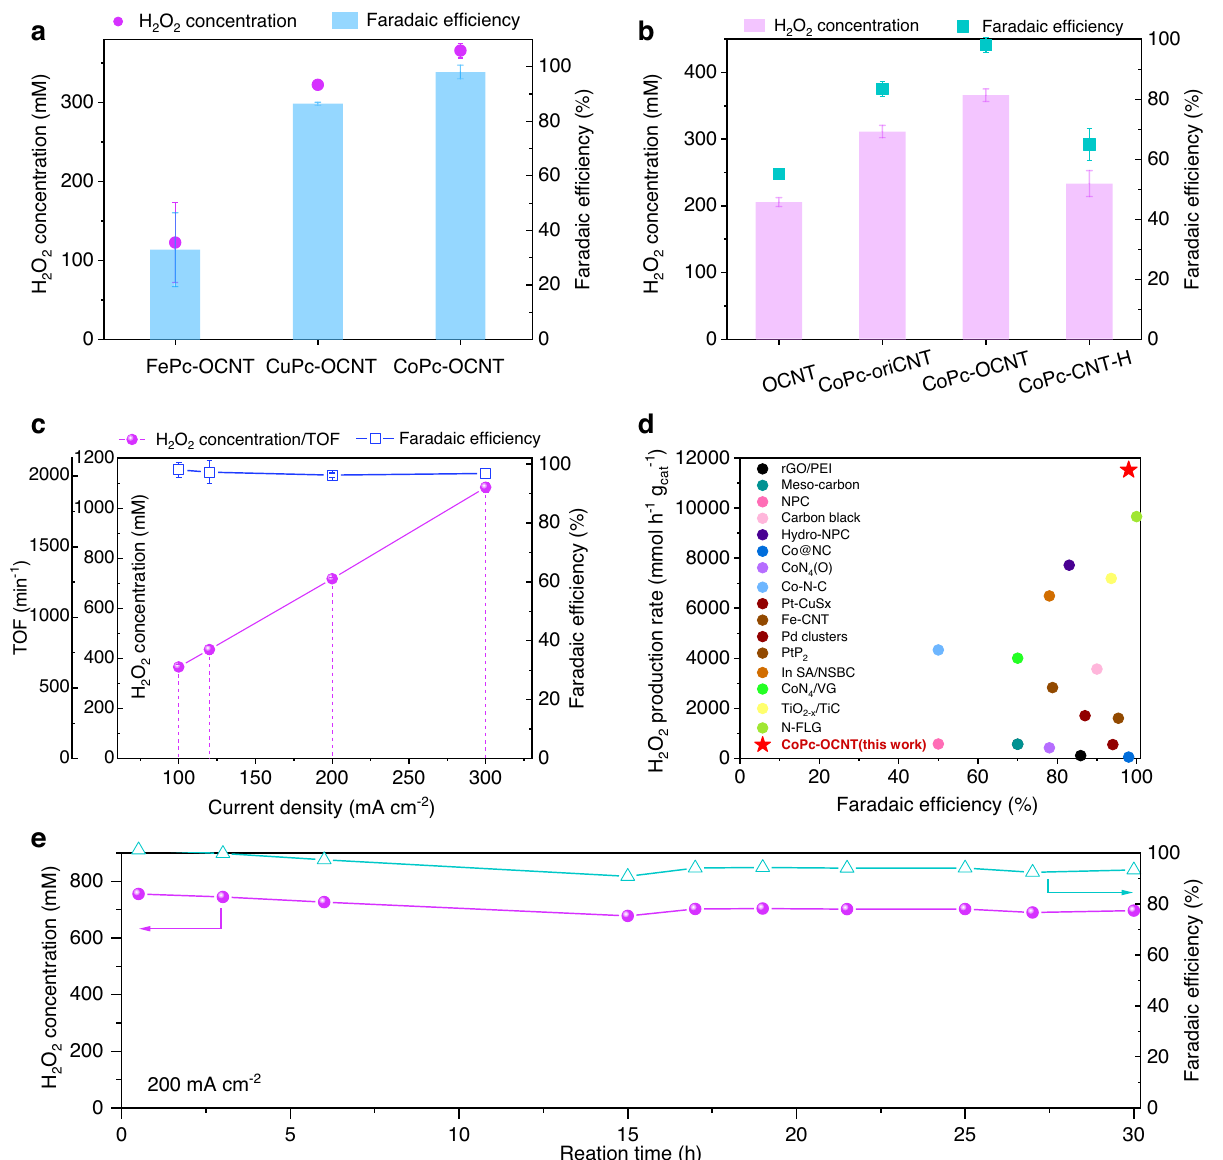
Fig. 5 | H 2 O 2 electrosynthesis performance in a fl ow-cell electrolyzer based on the gas-diffusion cathode. a, b Concentrations of H 2 O 2 directly outputted from electrolyzer and the Faradaic ef fi ciency of FePc-OCNT, CoPc-OCNT, CuPc-OCNT, OCNT, CoPc-oriCNT or CoPc-CNT-H cathodes at 100mAcm − 2 (Data points and error bars represent the average and standard deviation of data from triplicate parallel tests). c H 2 O 2 concentration, Faradaic ef fi ciency and TOF values of CoPc- OCNT at 100, 120, 200 and 300mAcm − 2 . d H 2 O 2 production rate of CoPc-OCNT